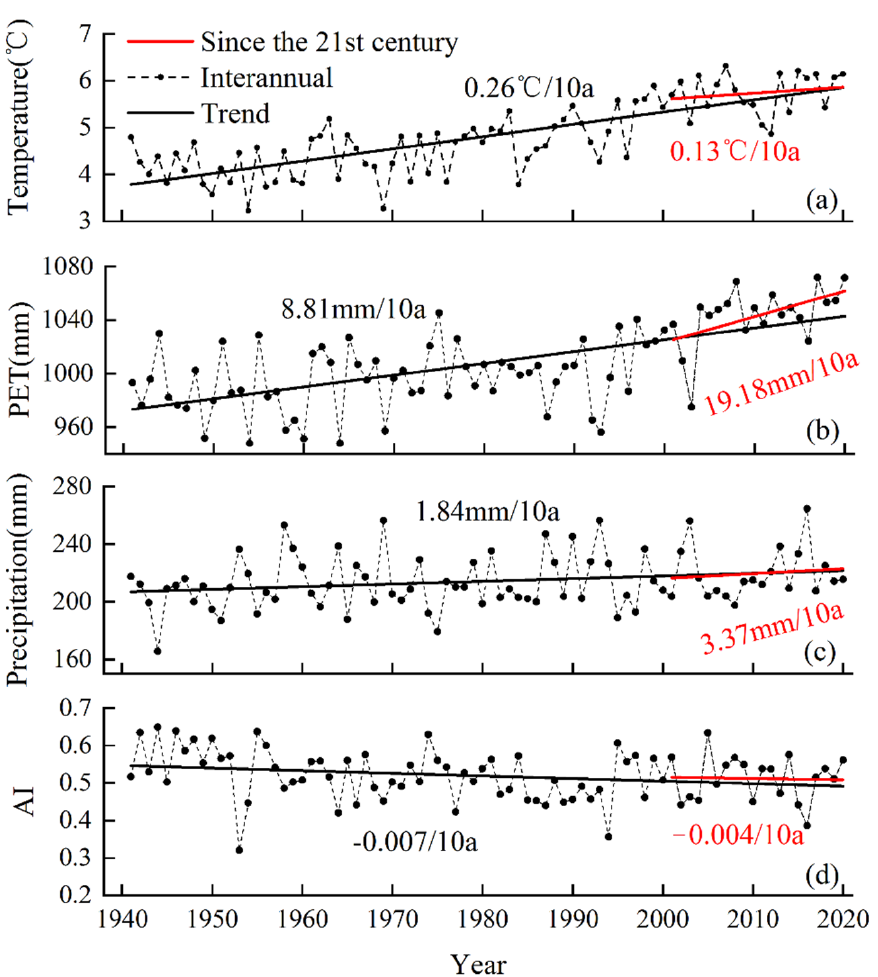
Figure 3. Interannual variations in temperature ( a ), PET ( b ), precipitation ( c ) and AI ( d ) from 1941 to 2020. Table 2. PCC between four ocean oscillation indexes and precipitation in the Pan-Central-Asia arid